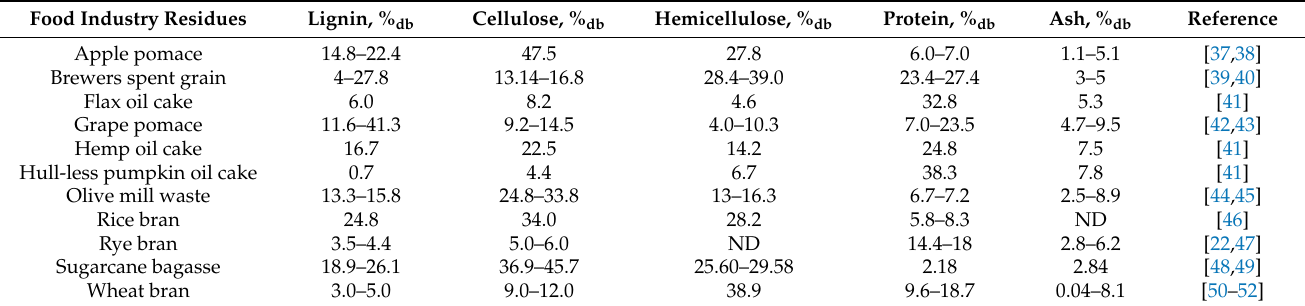
Table 2. Chemical composition of common food industry